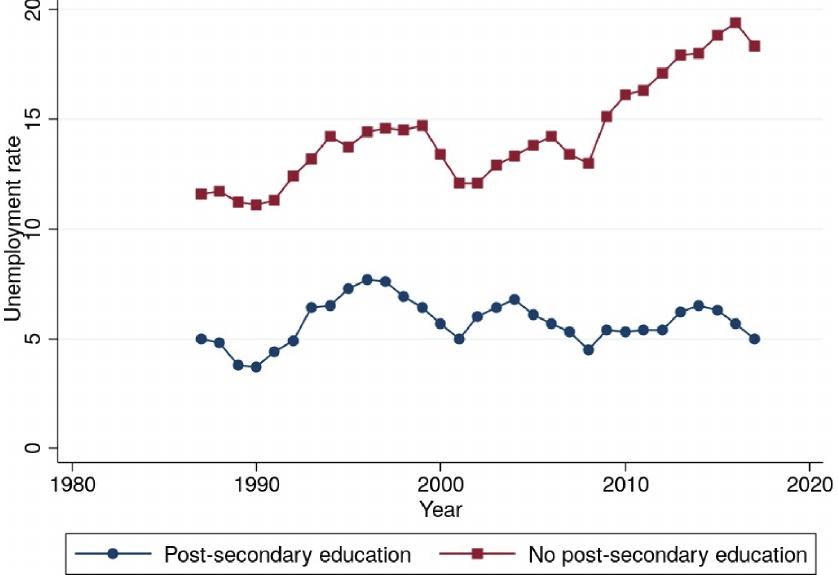
Figure 1 Unemployment gap by education in France,